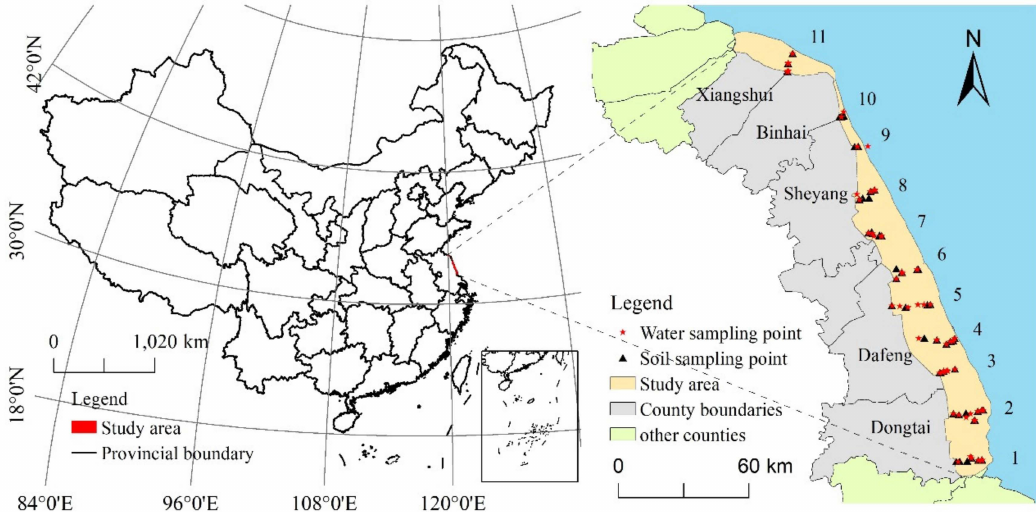
Figure 1. Geographical location of the study area. The sampling routes were named after the port and river names nearby the shorelines, which, from the south to the north, were the Xinchuan Port route (1), Liangduo River route (2), Chuandong Port route (3), Wanggang Port route (4), Wanzhuang Port route (5), Doulong Port route (6), Xinyang Port route (7), Sheyang River route (8), Shuangyang Port route (9), Biandan Port route (10) and New Huai River estuary route